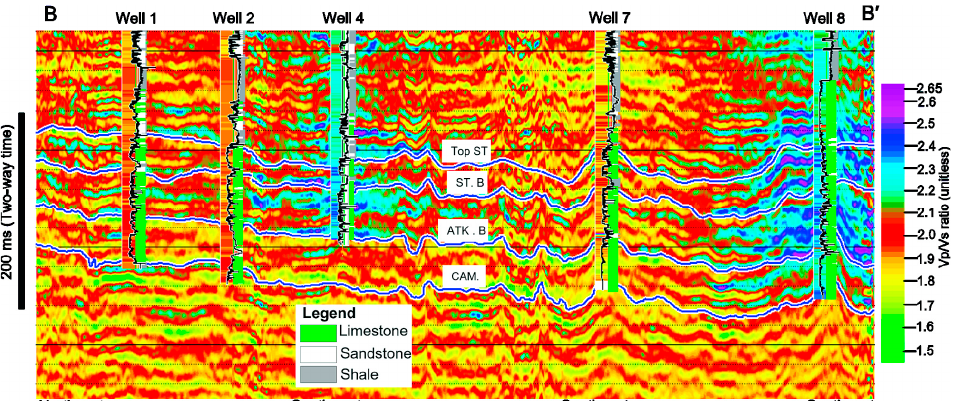
Figure 13. Cross section B–B ′ of inverted Vp/Vs-ratio volumes passing through wells 1, 2, 4, 7, and 8. Note: all inserted logs and abbreviated horizon names as defined in Figure 8.